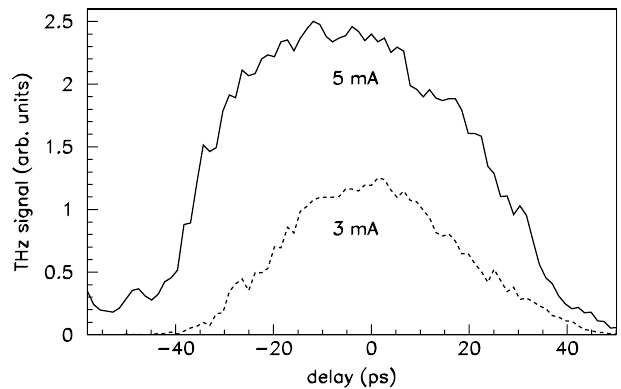
FIG. 3. THz radiation intensity from energy-modulated elec- trons under variation of the laser pulse delay for an electron bunch current of 3 and 5 mA.